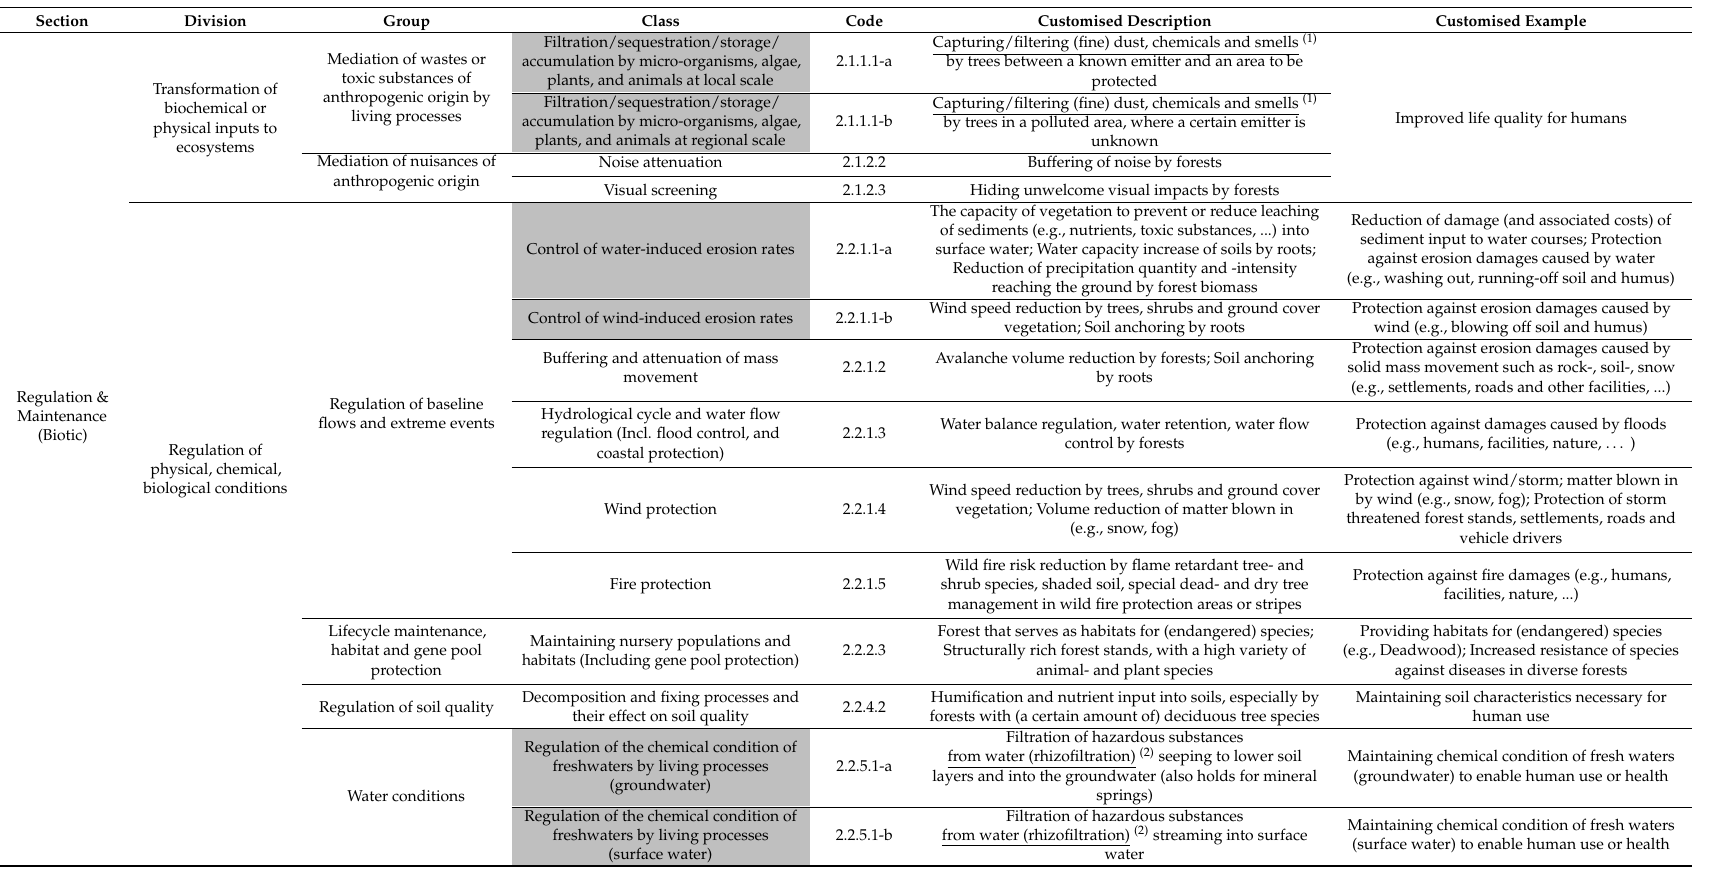
Table 4. Customised CICES Framework for regulating services (biotic). Source: own representation. Grey-shaded cells contain a synthesis between CICES and German FFM terminology, due to a complementary and more differentiated level of information. Underlined text is inspired by (1) [43] and (2) [30]. Section Division Group Class Code Customised Description Customised